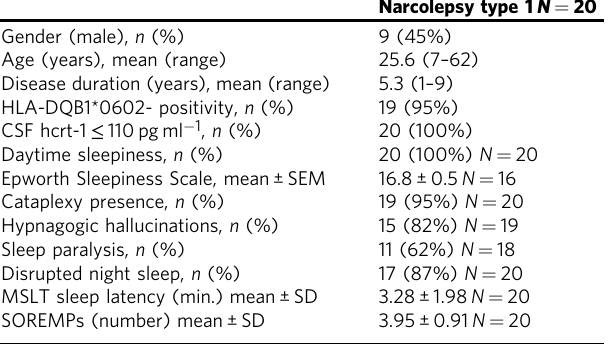
Narcolepsy type 1 N =